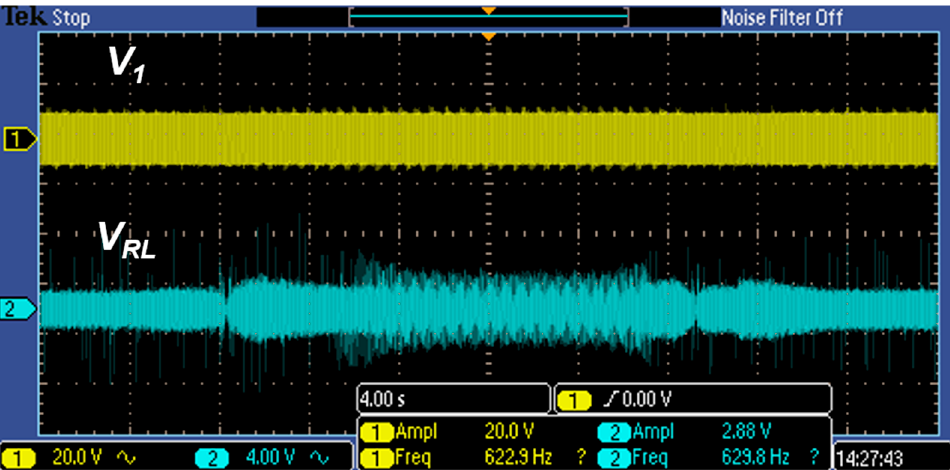
Figure 7. Misalignment result of the scheduled dynamic WPT.